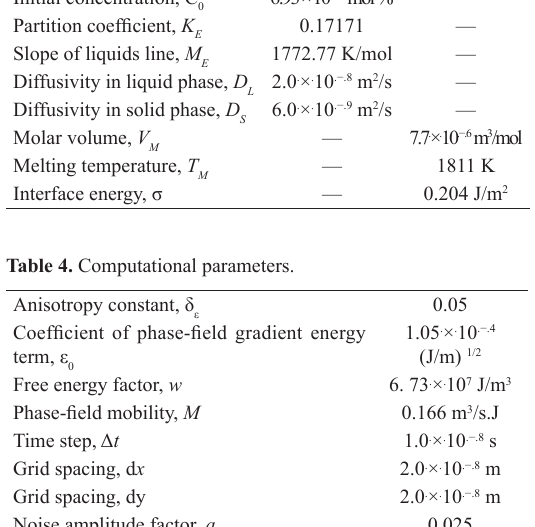
Figure 6. Comparison of dendritic morphology between phase-field model with adaptive computational domain (a) and fixed domain